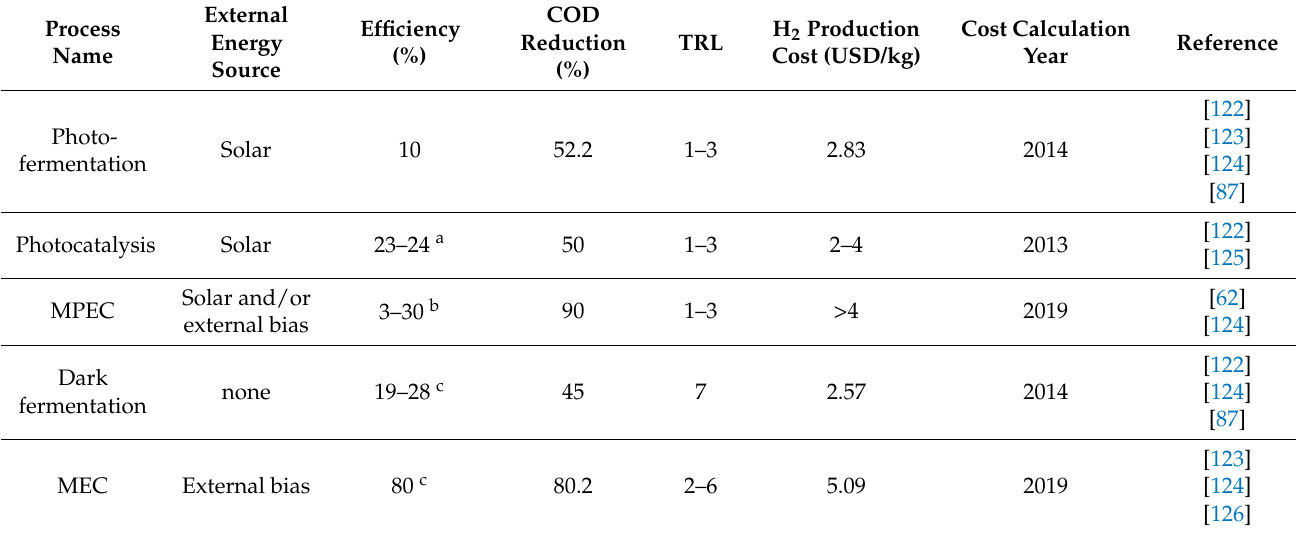
Table 13. Comparative assessment of H 2 -generating